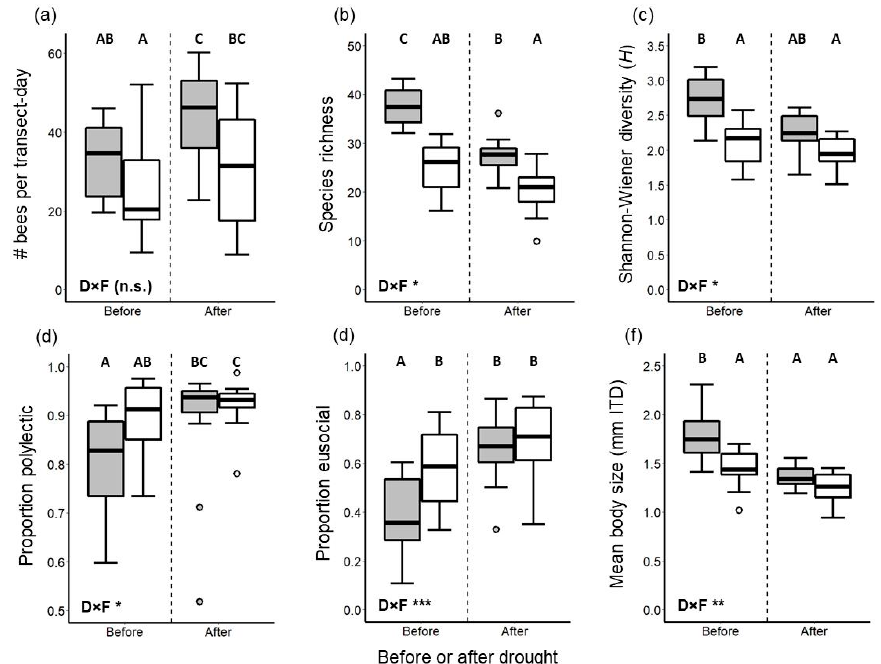
Figure 3. Comparisons of bee assemblages in scrub reserve plots (gray boxes) and scrub fragment plots (white boxes) before (2011 and 2012) and after (2015 and 2016) a severe drought event in 2014. Panels ( a – f ) depict different characteristics of bee assemblages; in panel ( f ), “ITD” stands for intertegular distance. Boxplots are as in Figure 2b; circles indicate outliers, if any. “D×F” denotes the statistical significance of the interaction between drought status and fragmentation status: n.s. p > 0.05, * p ≤ 0.05, ** p ≤ 0.01, *** p ≤ 0.001.